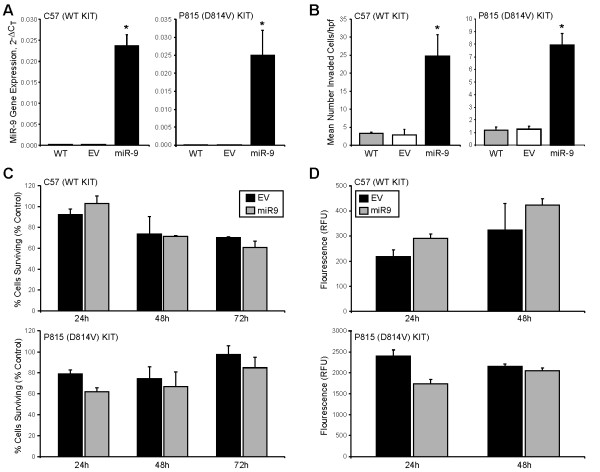
Overexpression of miR-9 enhances invasion of malignant mast cells and has no effect on cell proliferation or apoptosis. (A) Mouse P815 and C57 mast cells transduced with pre-miR-9-3 lentivirus or empty vector control were sorted to greater than 95% purity based on GFP expression. MiR-9 levels were assessed by real-time PCR in wild-type, empty vector, and miR-9 expressing cells (*p < 0.05). Three independent experiments were performed and all reactions were performed in triplicate. (B) Mouse P185 and C57 mast cells transduced with either empty vector or pre-miR-9-3 lentivirus were transferred onto cell culture inserts coated with Matrigel® for 24 hrs. After incubation, membranes were stained and cells that had invaded the membrane were counted in ten independent 20x hpf for each sample. Three independent experiments were performed and all assays were performed in triplicate wells (*p < 0.05). (C) Mouse P185 and C57 mast cells were transduced with either empty vector or pre-miR-9-3 lentivirus vector and cell proliferation was analyzed at 24, 48, and 72 hours using the CyQUANT method. Nontransduced P815 and C57 cells served as non-treated controls. Three independent experiments were performed and all samples were seeded in triplicate wells. Values are reported as percentage of untransduced control cells. (D) Mouse P185 and C57 mast cells transduced with either empty vector or pre-miR-9-3 lentivirus were assessed for apoptosis at 24 and 48 hours by measuring active caspase-3/7 using the SensoLyte® Homogeneous AMC Caspase-3/7 Assay kit. Relative fluorescence units are reported after subtraction of fluorescence levels of wells with medium only.